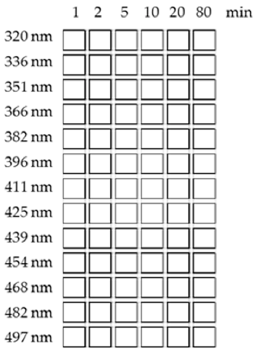
Figure 1. Irradiation wavelength and irradiation time.